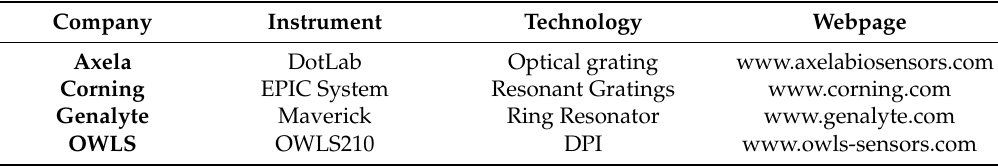
Table 2. Commercial solutions of biosensors based on integrated